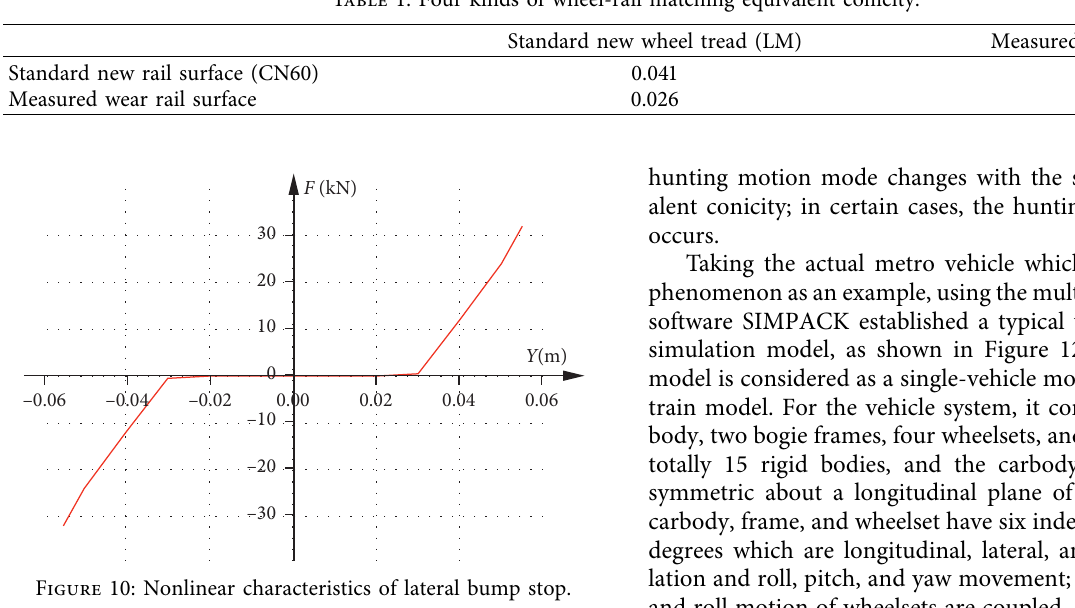
Figure 9: Wheel-rail contact geometry relationship. (a) Standard wheel and standard rail. (b) Measured wheel and standard rail. (c) Standard wheel and measured rail. (d) Measured wheel and measured Table 1: Four kinds of wheel-rail matching equivalent conicity.